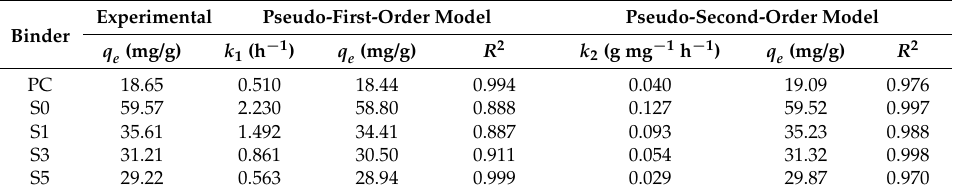
Table 3. Parameters of kinetic models of cesium adsorptions on various binder types.